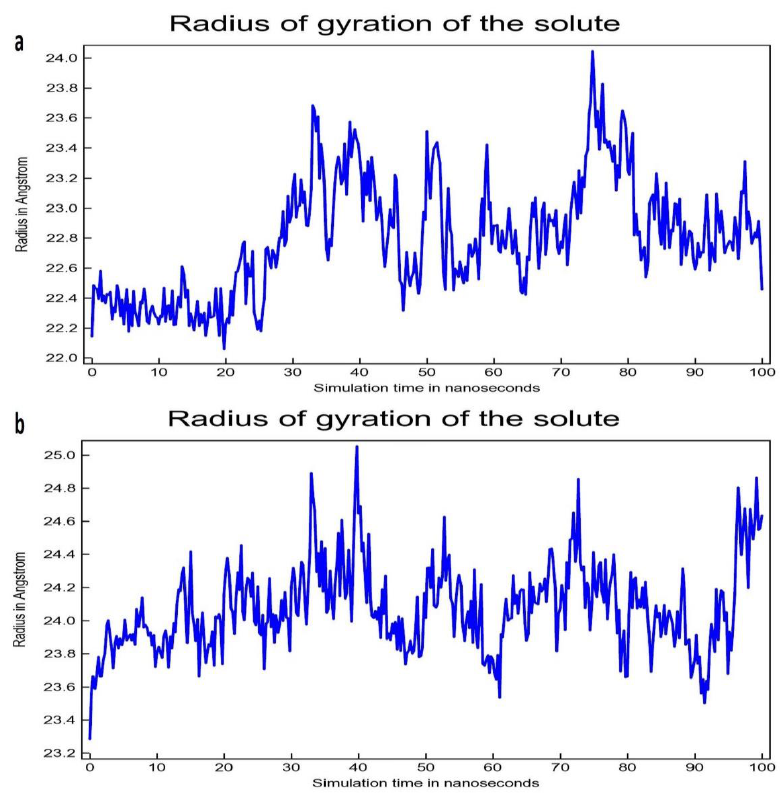
Figure 6. Radius of gyration of the solute protein for ( a ) DTQ-3CLpro complex ( b ) DTQ-NSP15 with respect to the simulation time of 100 ns.